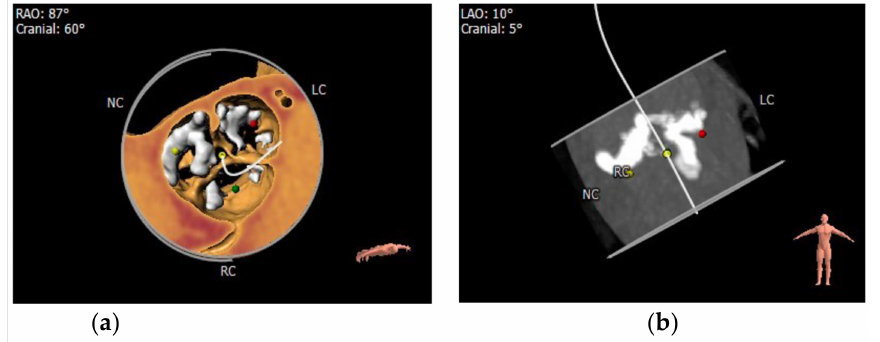
Figure 4. ( a ) Calcium degree and morphology evaluation of the aortic valve by CT. ( b ) LAO–cranial view for calcium location